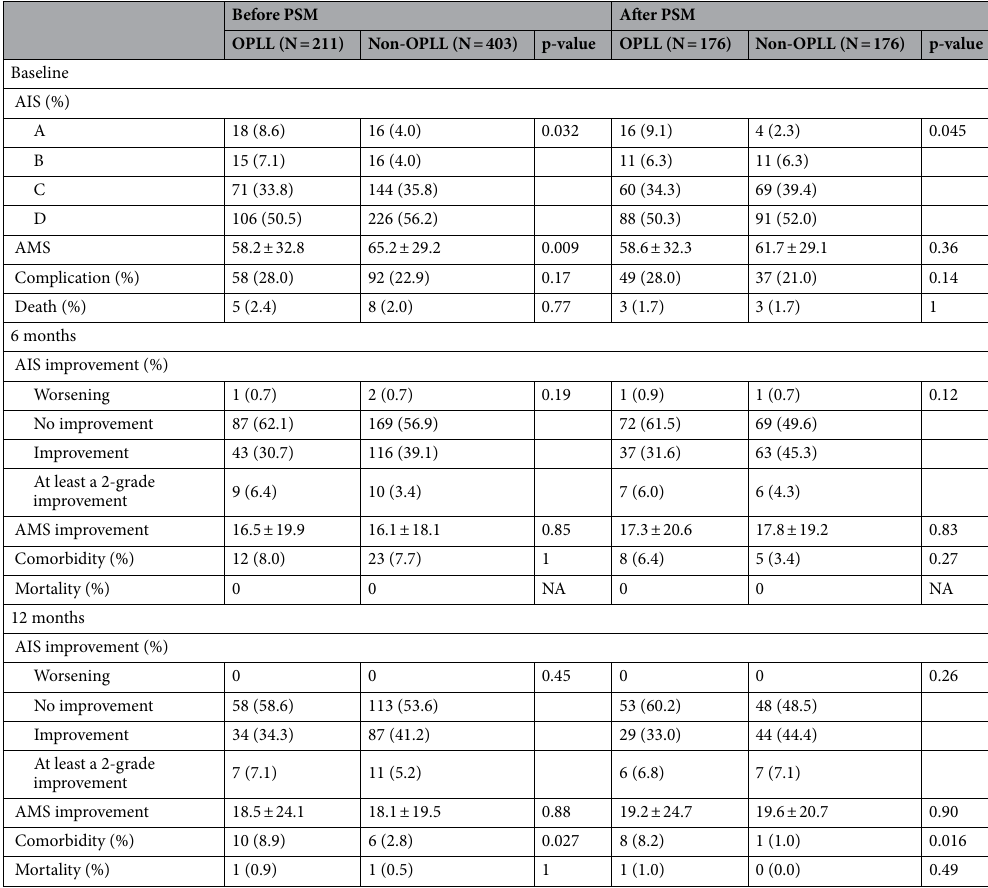
Table 6. A comparison of the primary and secondary outcomes between the OPLL and non-OPLL groups with CSCI without bone injury. PSM, propensity score matching; OPLL, ossification of the posterior longitudinal ligament; CSCI, cervical spinal cord injury; AIS, American Spine Injury Association impairment scale; and AMS, American Spine Injury Association motor score.